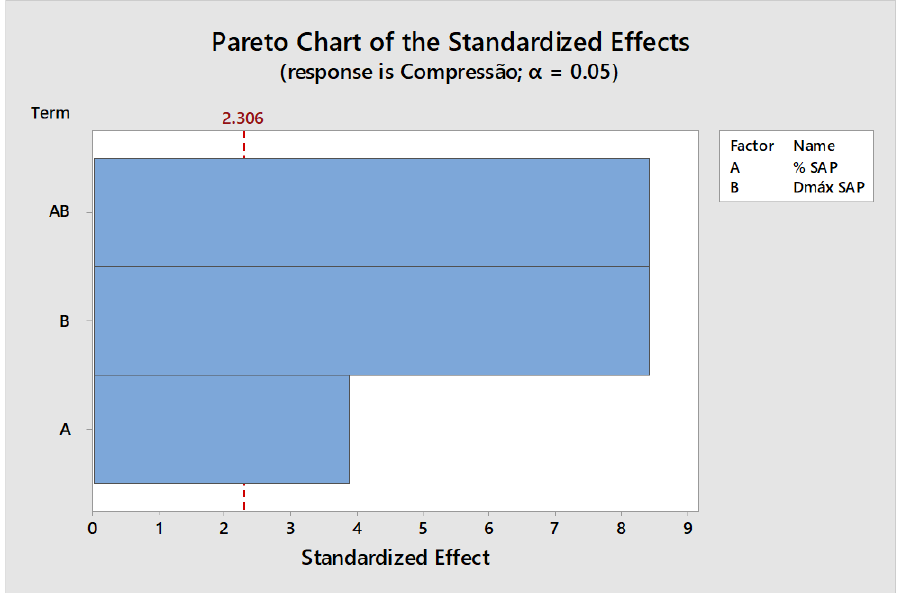
Figure 4. Effects of imposed factors on the performance of strength.